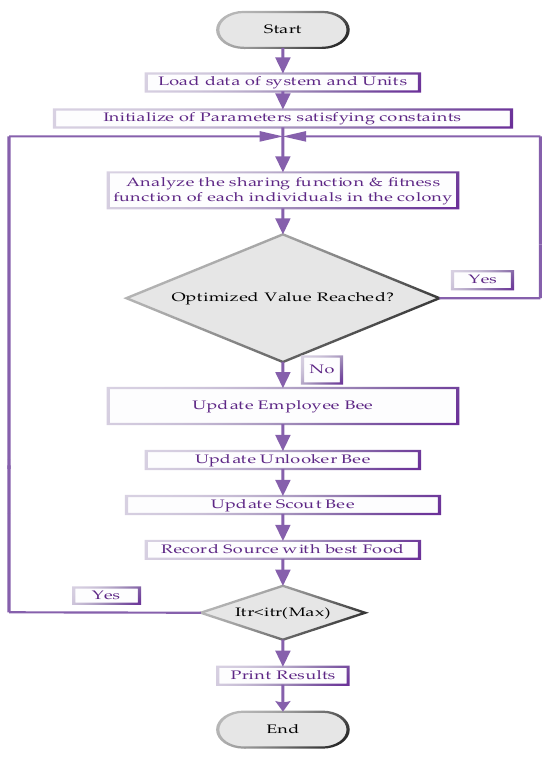
Figure 4. Flowchart of the ABC algorithm.